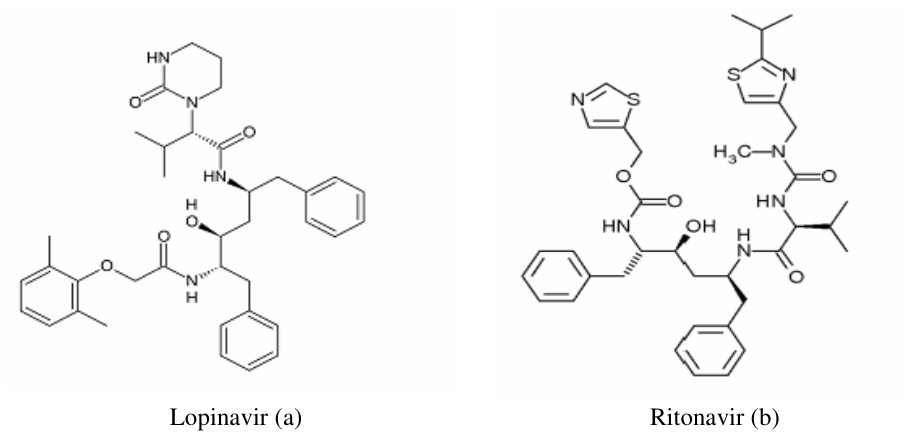
Figure 1. Structures of lopinavir and